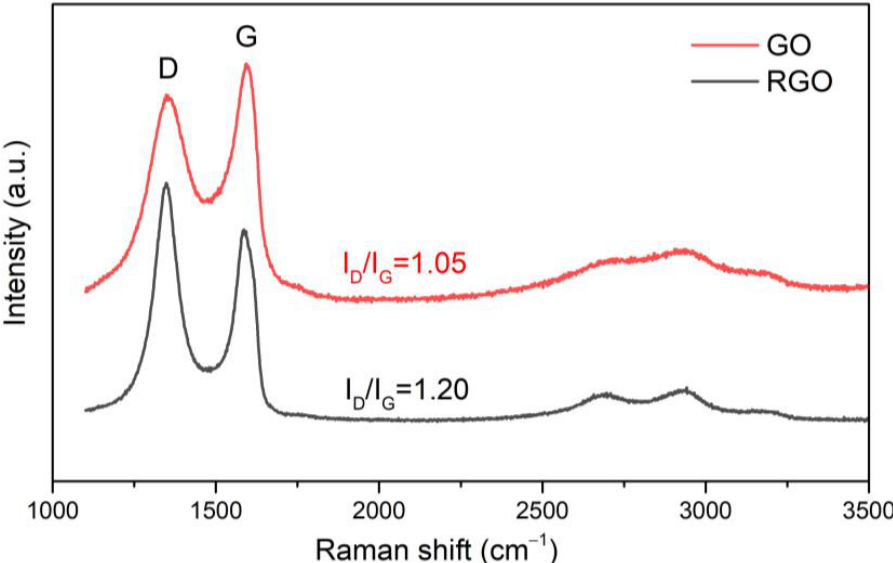
Figure 6. Raman spectra of graphene oxide and reduced graphene oxide.